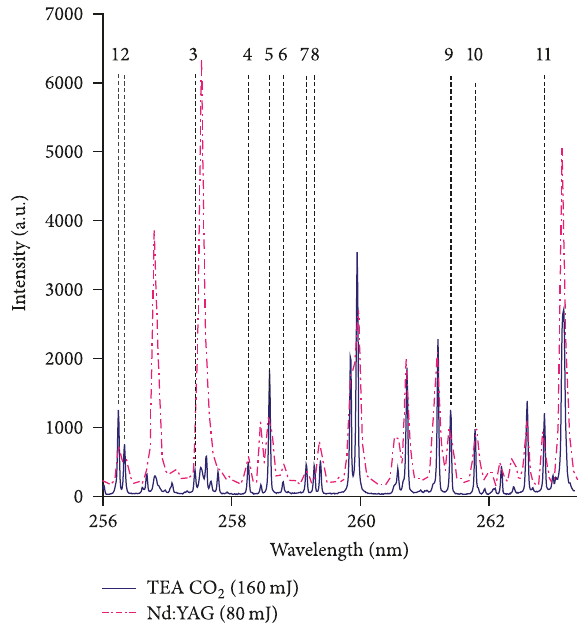
Figure 3: Fe II spectral lines (listed in Table 1) used for calculation of plasma temperature.